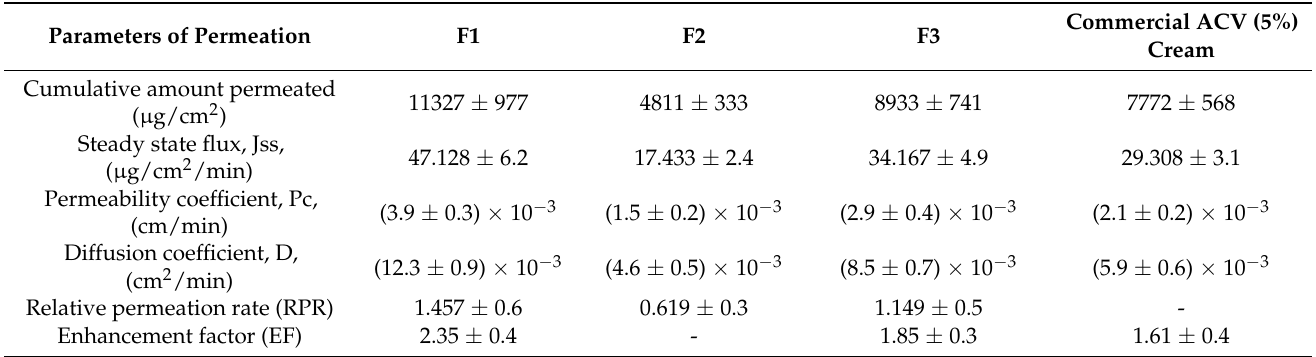
Table 3. Parameters of permeation of ACV across rat skin for different formulations. Data are expressed as mean ± SD ( n =